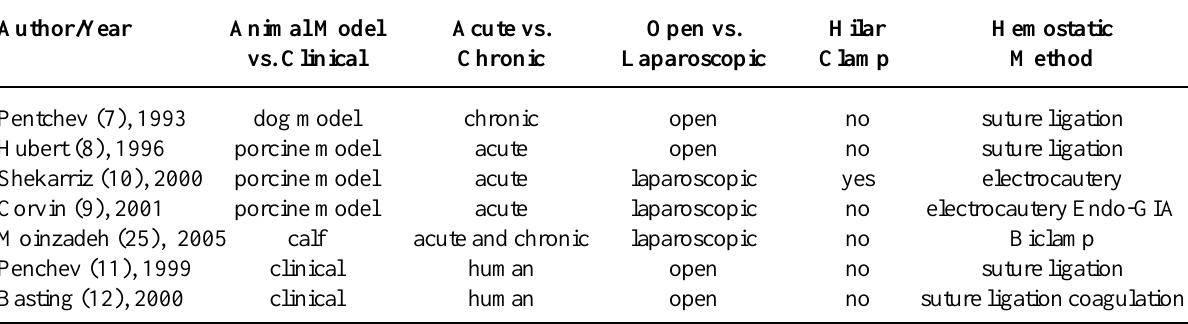
Table 2 – Use of water jet during laparoscopic partial